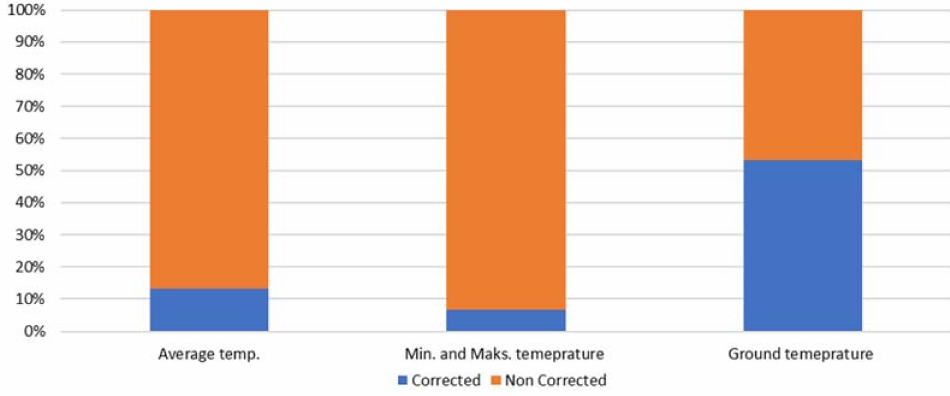
Figure 10. Ratio of models that have improved by adding information from the previous